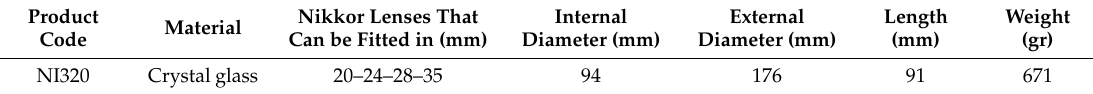
Figure 8. Measurement of the distance D EP2F between the entrance pupil and the flange. Table 1. Manufacturing parameters of the tested NiMAR hemispherical